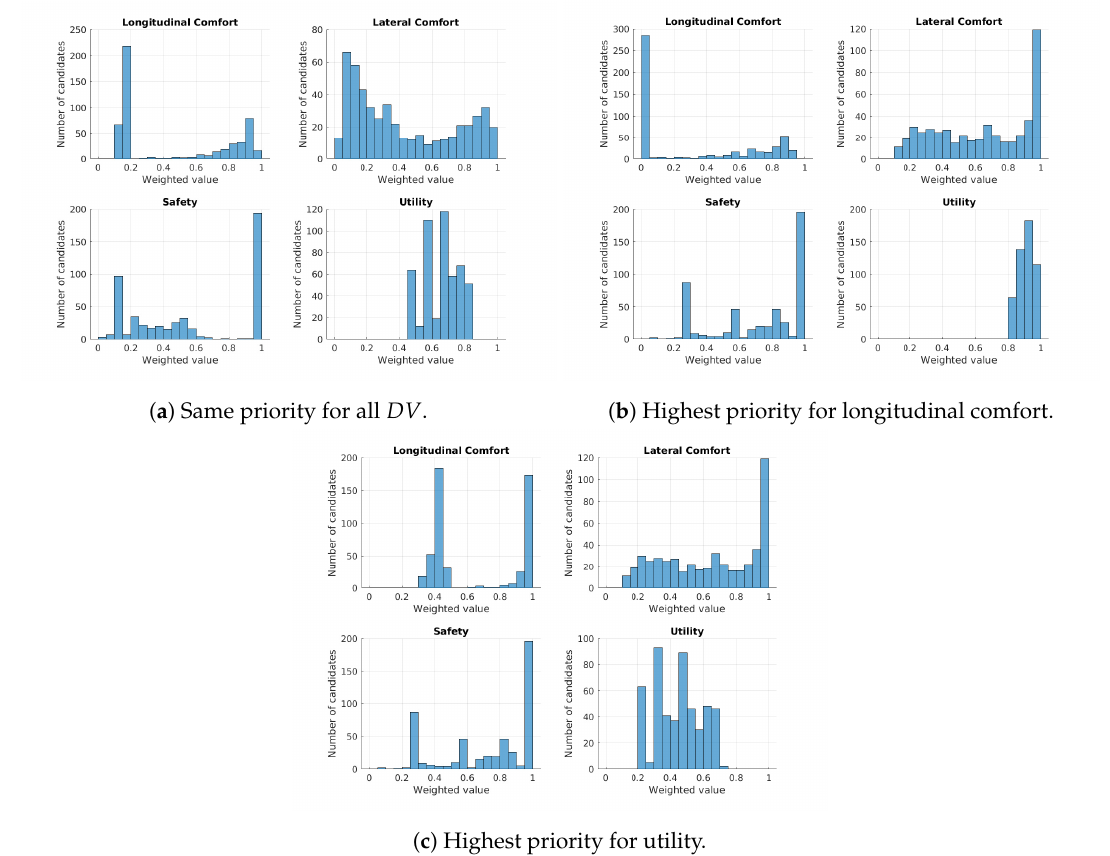
Figure 12. Histogram of the DV of Γ when different weight configurations are applied.